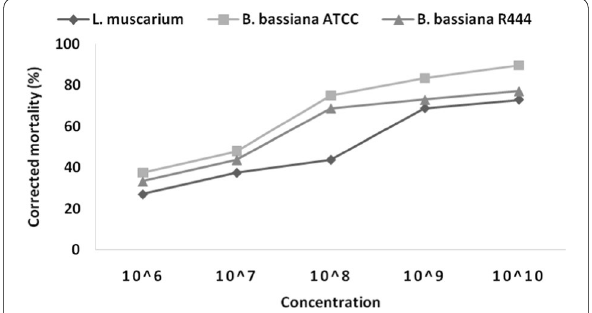
Fig. 2 Corrected mortality of second instar Tuta absoluta larvae by the first method with Beauveria bassiana ATCC, B. bassiana R444 and Lecanicillium muscarium